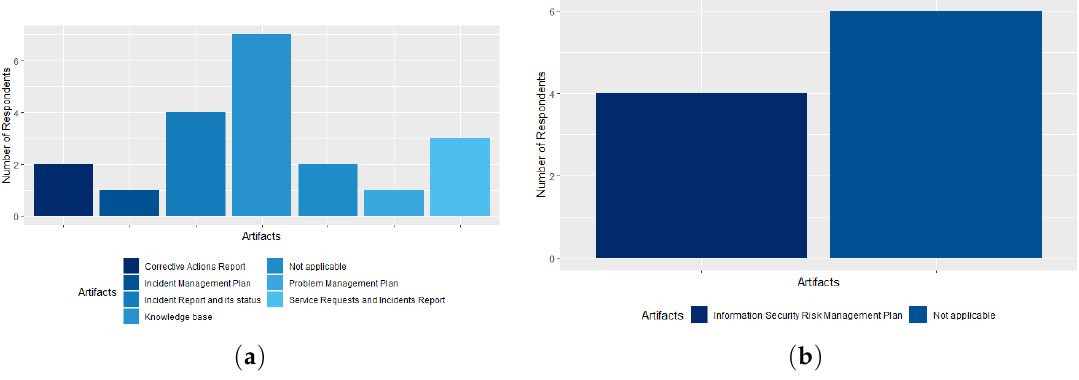
Figure 12. ( a ) The Incident and Problem Management Process (Service Desk) artifacts; ( b ) the Information Security Risk Management process